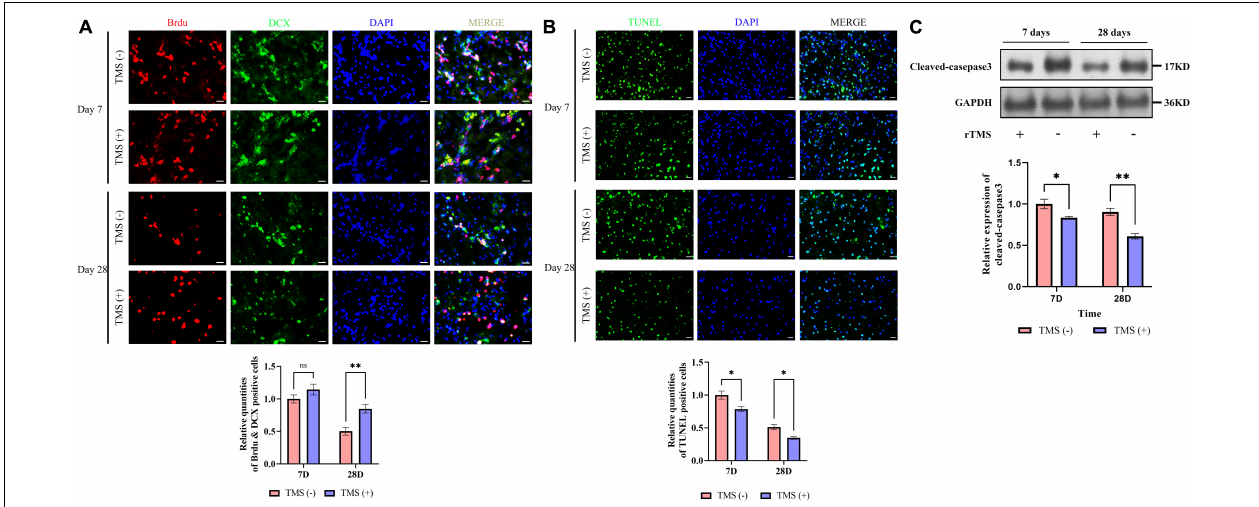
FIGURE 3 | Effects of rTMS on neural regeneration and apoptosis. (A) Quantitative analysis of BrdU + and DCX + newborn neural precursor cells (NPCs) in TMS (–) and TMS (+) groups ( n = 5). Quantity of NPCs in TMS (–) group of day 7 was normalized as control. (B) Quantitative analysis of TUNEL-positive apoptotic cells in transcranial magnetic stimulation (TMS) (–) and TMS (+) groups ( n = 3). Quantity of TUNEL-positive cells in TMS (–) group of day 7 was normalized as control. (C) Western blotting analysis of cleaved-caspase3 in TMS (–) and TMS (+) groups ( n = 4). Expression levels of cleaved-caspase3 in TMS (–) group of day 7 were normalized as control. Data are shown as mean ± SEM. Statistical significance was determined with the unpaired Student’s t -test. Scale bar, 10 µ m, * P < 0.05 and ** P < 0.01, and ns means no significant.